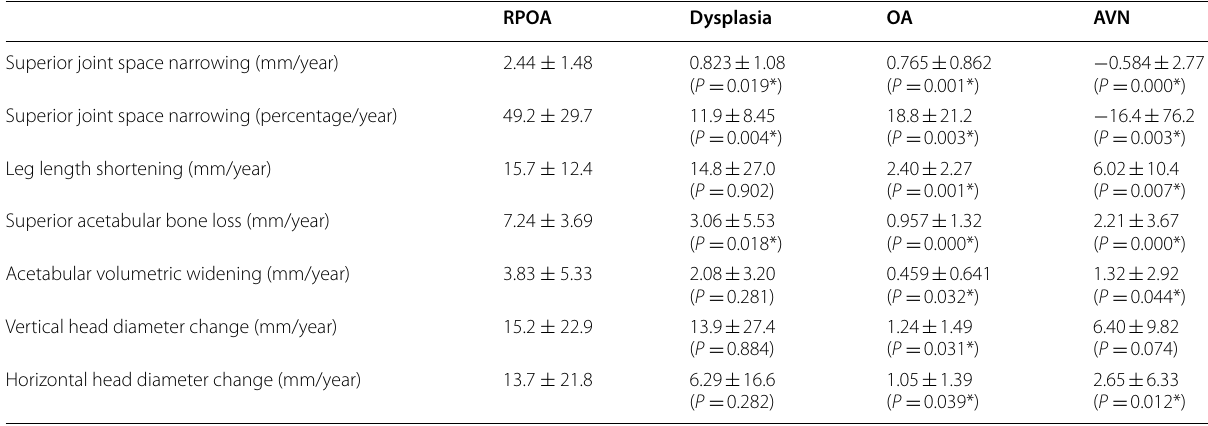
standard deviation ±